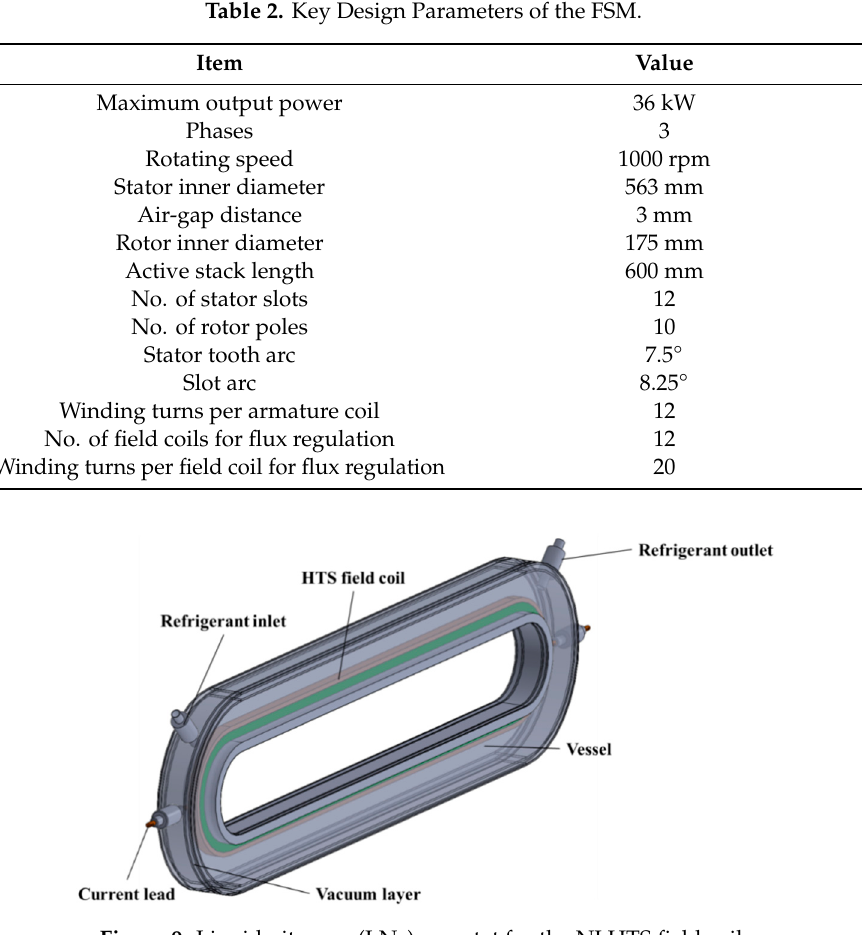
Figure 9. Liquid nitrogen (LN 2 ) cryostat for the NI HTS field coil.